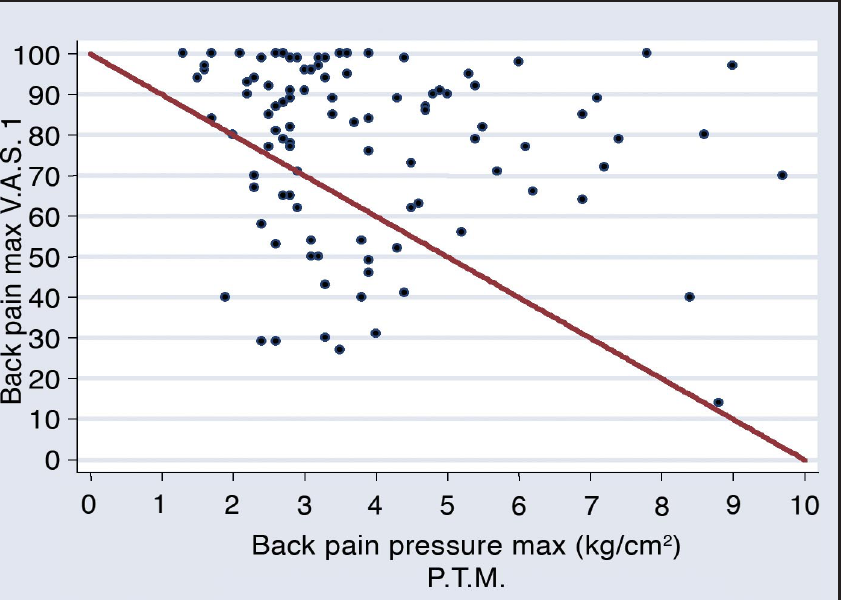
Figure 1: Scatter plot of the maximum pressure pain vs the patient perception on the V.A.S. 1.